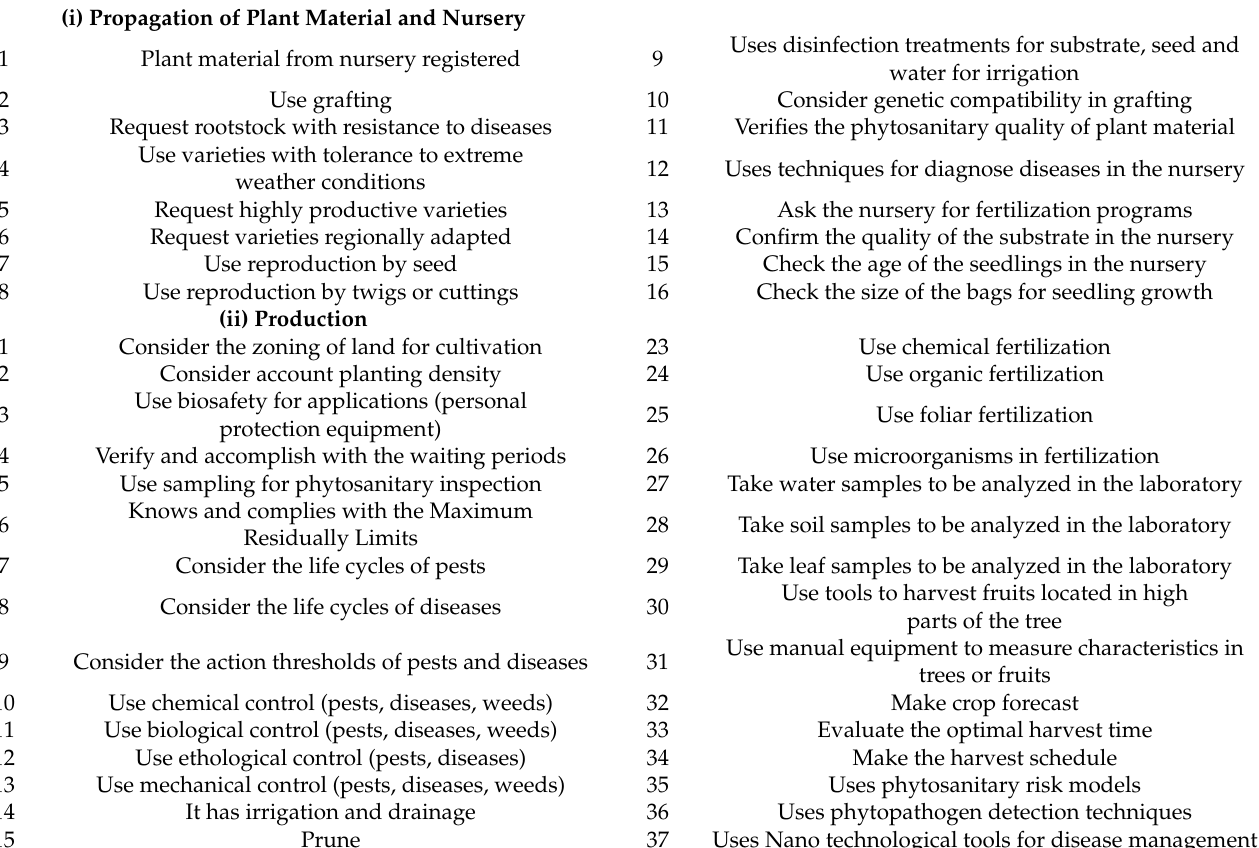
Table A1. Technologies Evaluated According to Frequency of Use for Avocado